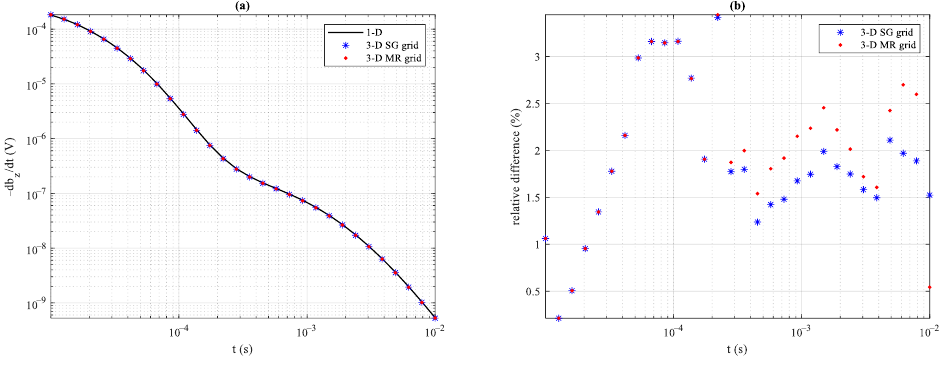
Figure 4. Example 1: ( a ) forward modeling responses; ( b ) relative differences of the 3-D SG and MR grid solutions against the 1-D semi-analytical